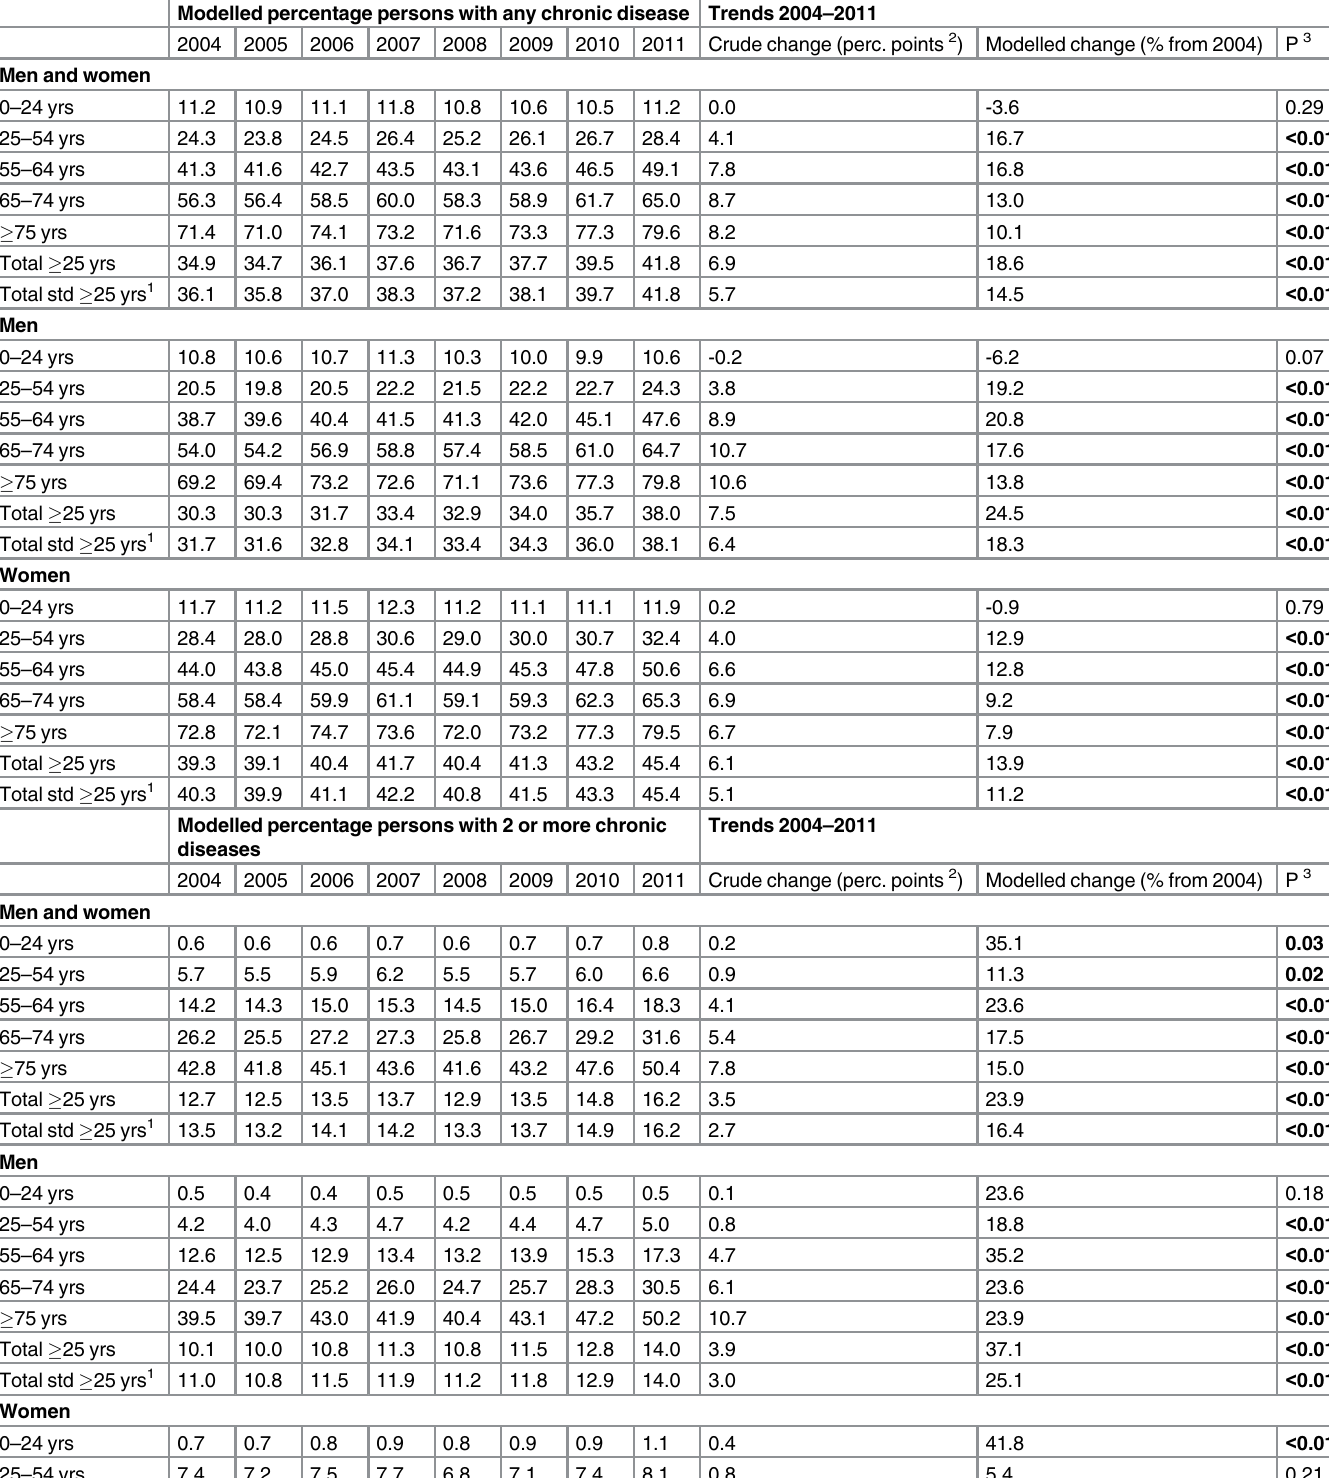
Table 1. Trends in the prevalence of diagnosed chronic diseases and multimorbidity in general practices over the period 2004 – 2011. Modelled percentage persons with any chronic disease Trends 2004 – 2011 2004 2005 2006 2007 2008 2009 2010 2011 Crude change (perc. points 2 ) Modelled change (% from 2004) P 3 Men and